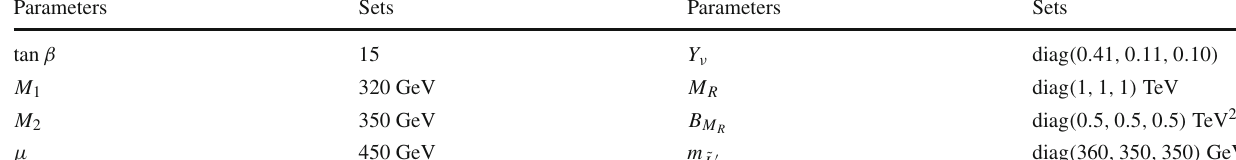
Table 2 The sets of fixed model parameters, defined at μ NP scale Parameters